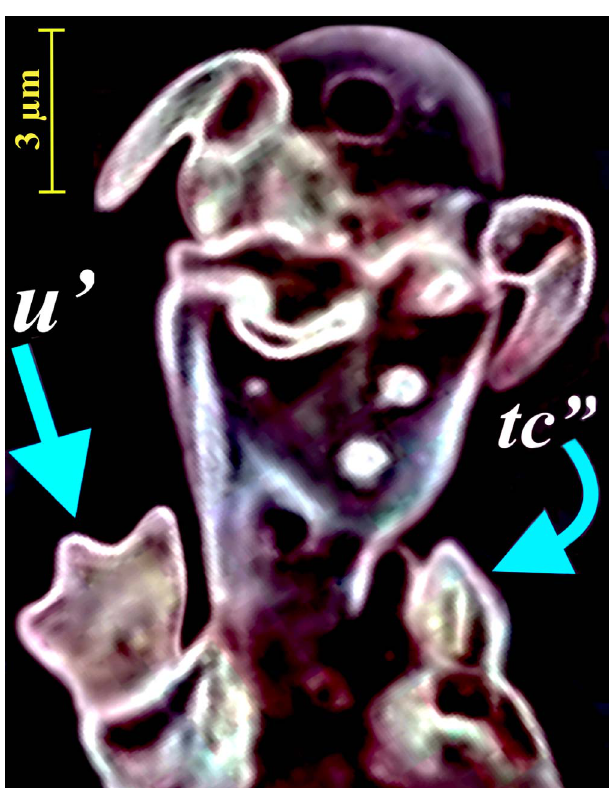
Figure 6. Phase-contrast micrograph of tarsus III in Eutarsopolipus pulcher n. sp. (adult female) representing modi fi ed trifurcate seta u 0 and spur-like seta tc 00